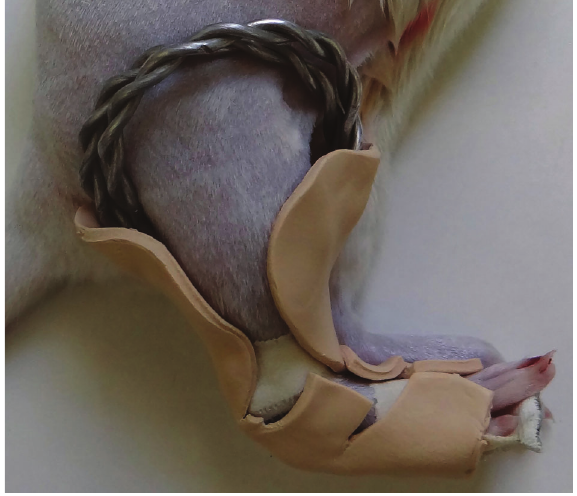
Figure 1. Fractured right hindlimb immobilized by an